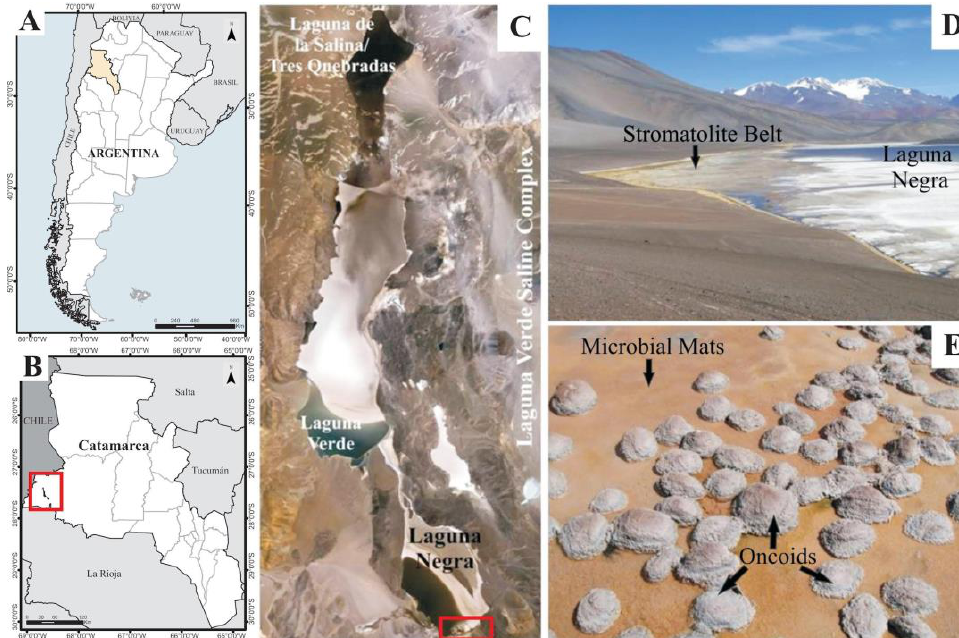
Figure 1. Geographical location of the studied area. ( A ) Argentina map showing the Catamarca Province in yellow; ( B ) Catamarca Province map showing the location of the Laguna Verde Saline Complex (red square); ( C ) Laguna Negra satellite image showing the study area location (red square); ( D ) Overview of the “Stromatolite Belt” in the southeastern shore of the Laguna Negra, where microbialites and microbial mats occur; ( E ) A detailed image of microbial mats surrounding oncoids in the “Stromatolite Belt”.